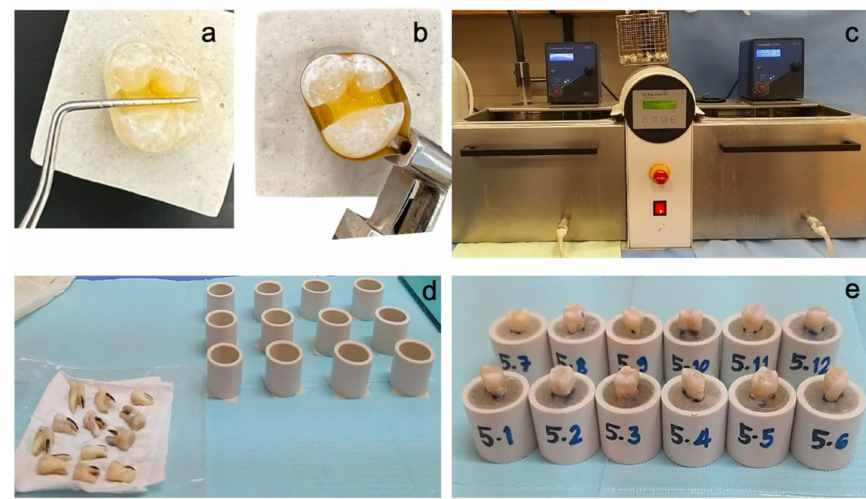
Figure 2. ( a ) Measurements of the cavities were taken for standardization purposes. ( b ) The matrix band placed around the cavity preparation to restore the proximal walls before adding the designated restorations to each group. ( c ) The restored teeth were placed in the thermocycling machine set at 10,000 cycles. ( d ) The aged teeth were mounted in special molds made specific for the Instron placement. ( e ) The molds were labeled according to group number (first digit) and sample number (second digit).